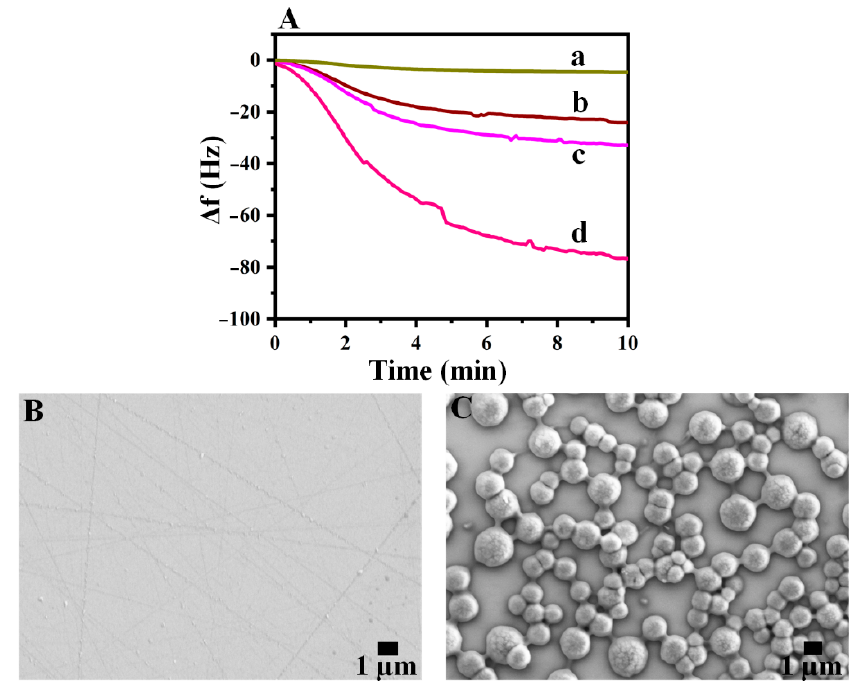
Figure 4. QCM responses ( A ) of bare electrode (a), MPA-treated electrode a (b), NHS/EDC-treated electrode B (c), and Ab 1 -functionalized electrode C (d); SEM images of delay line before ( B ) and after immobilization of Ab 1 ( C ).